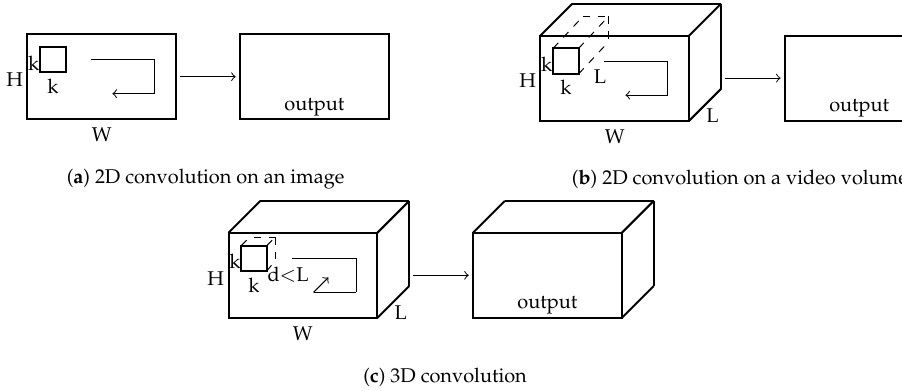
Figure 2. 2D and 3D convolution operations (adapted from the work in